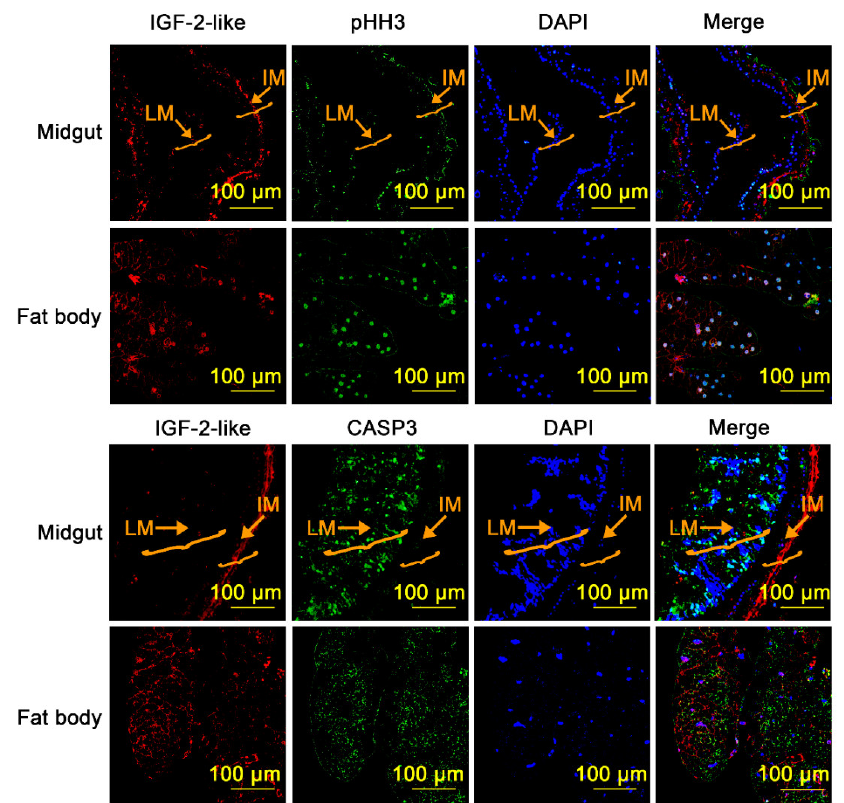
Figure 5. Immunofluorescence to show the tissue localization of IGF-2-like, pHH3, and CASP3. The midgut and fat body at 6th-96 h were used for immunofluorescence localization. An identical slide was double-immunoassayed to co-localized IGF-2-like and phospho-histone H3 or CASP3 by a sequential staining method. Red fluorescence represents IGF-2-like. The green fluorescence in above panels represents pHH3. The green fluorescence in below panels represents CASP3. LM: larval midgut. IM: imaginal midgut.